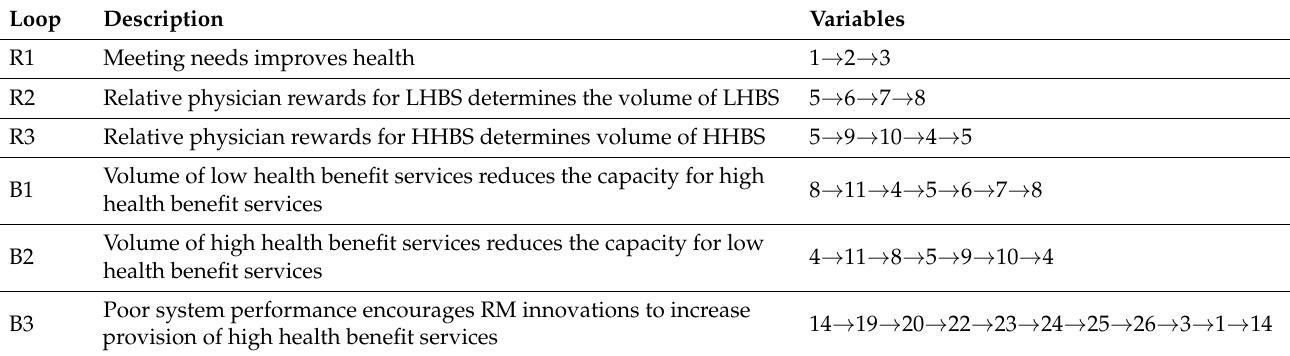
Table 1. Summary of causal loops emerging from the Causal Loop